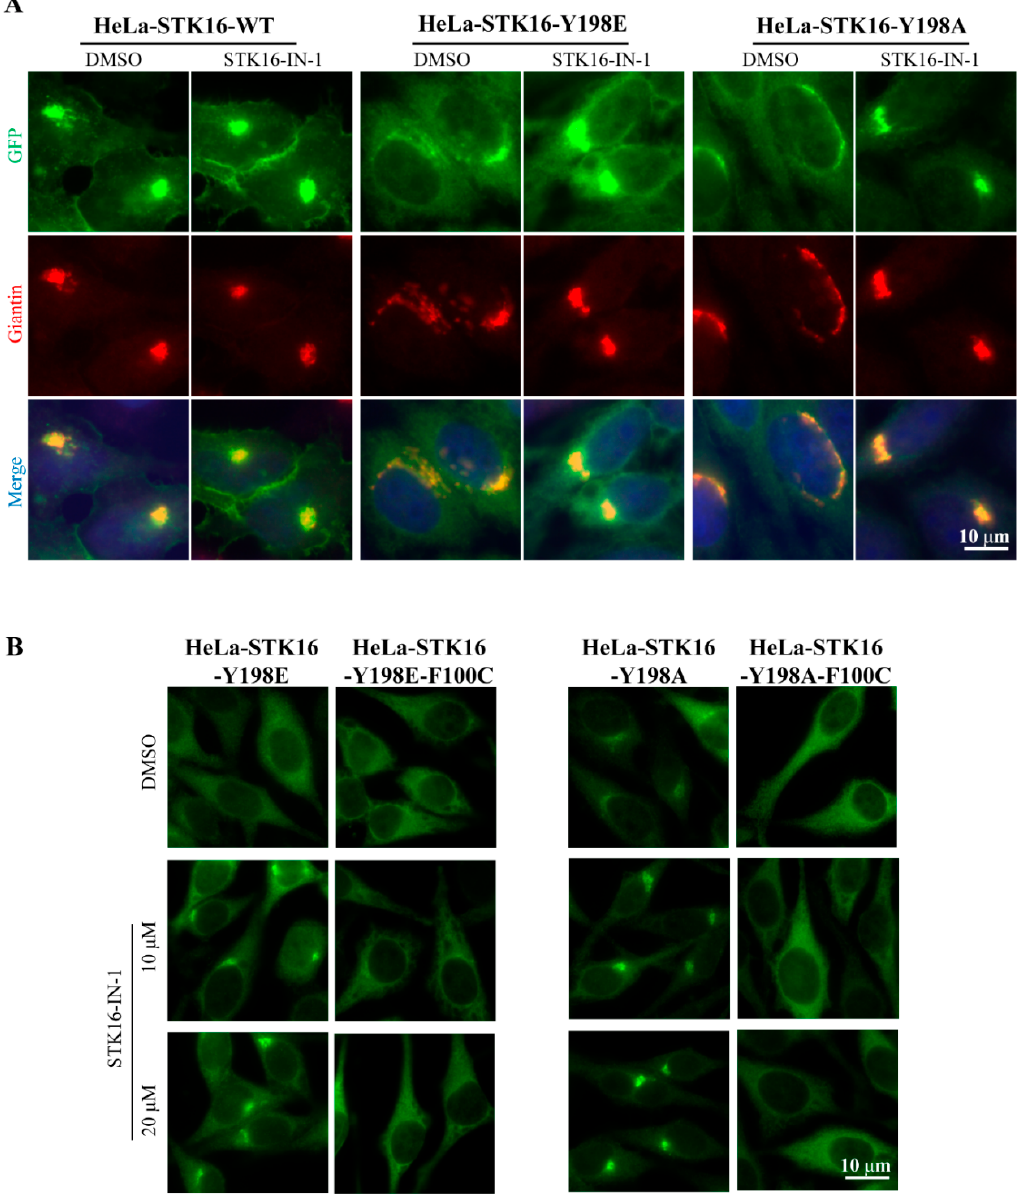
Figure 3. The kinase activity and Tyr198 phosphorylation of STK16 determines the localization of STK16. ( A ) HeLa-STK16 WT-GFP-FLAG, HeLa-STK16 Y198E-GFP-FLAG, and HeLa-STK16 Y198A-GFP-FLAG overexpression cell lines grown on coverslips were treated with DMSO or 10 μ M STK16 IN-1 for 8 h. Immunofluorescence used anti-GFP (green) and anti-Giantin (red) antibodies to analyze the localization of STK16. ( B ) HeLa cells stably expressing STK16 Y198E-GFP-FLAG and HeLa-STK16 Y198E-F100C-GFP-FLAG were treated with DMSO or 10 μ M, and 20 μ M STK16-IN-1 for 8 h. Experiments were repeated at least three times and representative results are shown. Scale bar, 10 μ m.